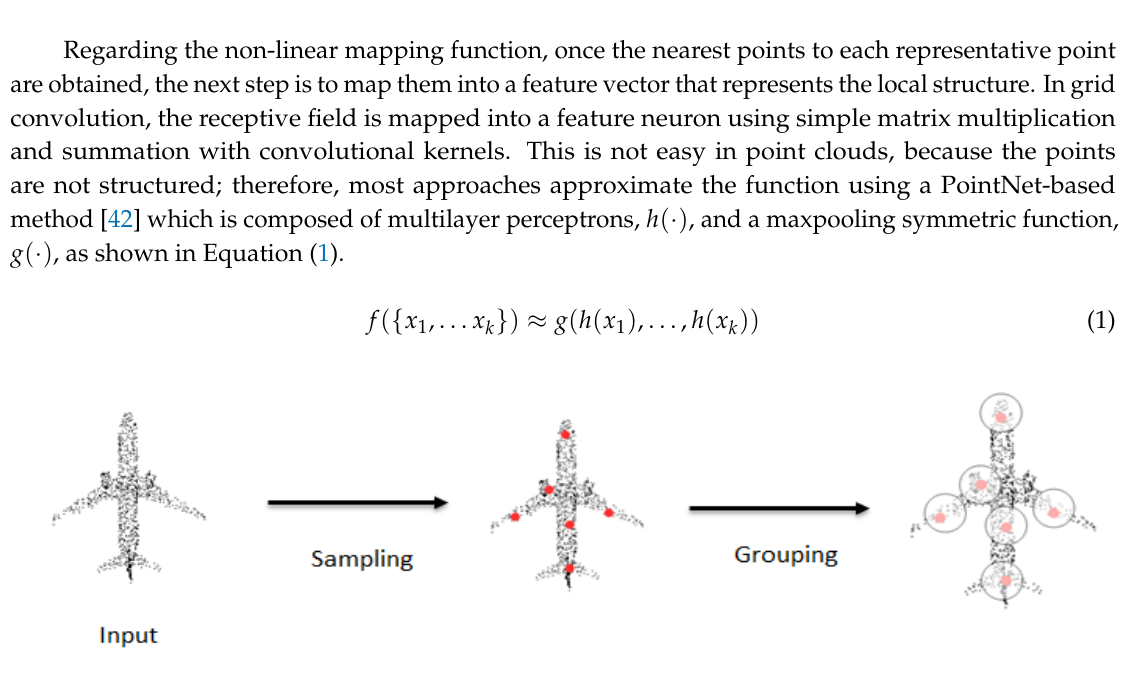
Figure 8. Sampling and grouping of points into local patches. The red dots are the centroid points selected using sampling algorithms, and the grouping shown is a ball query in which points are selected based on a certain radius distance to the